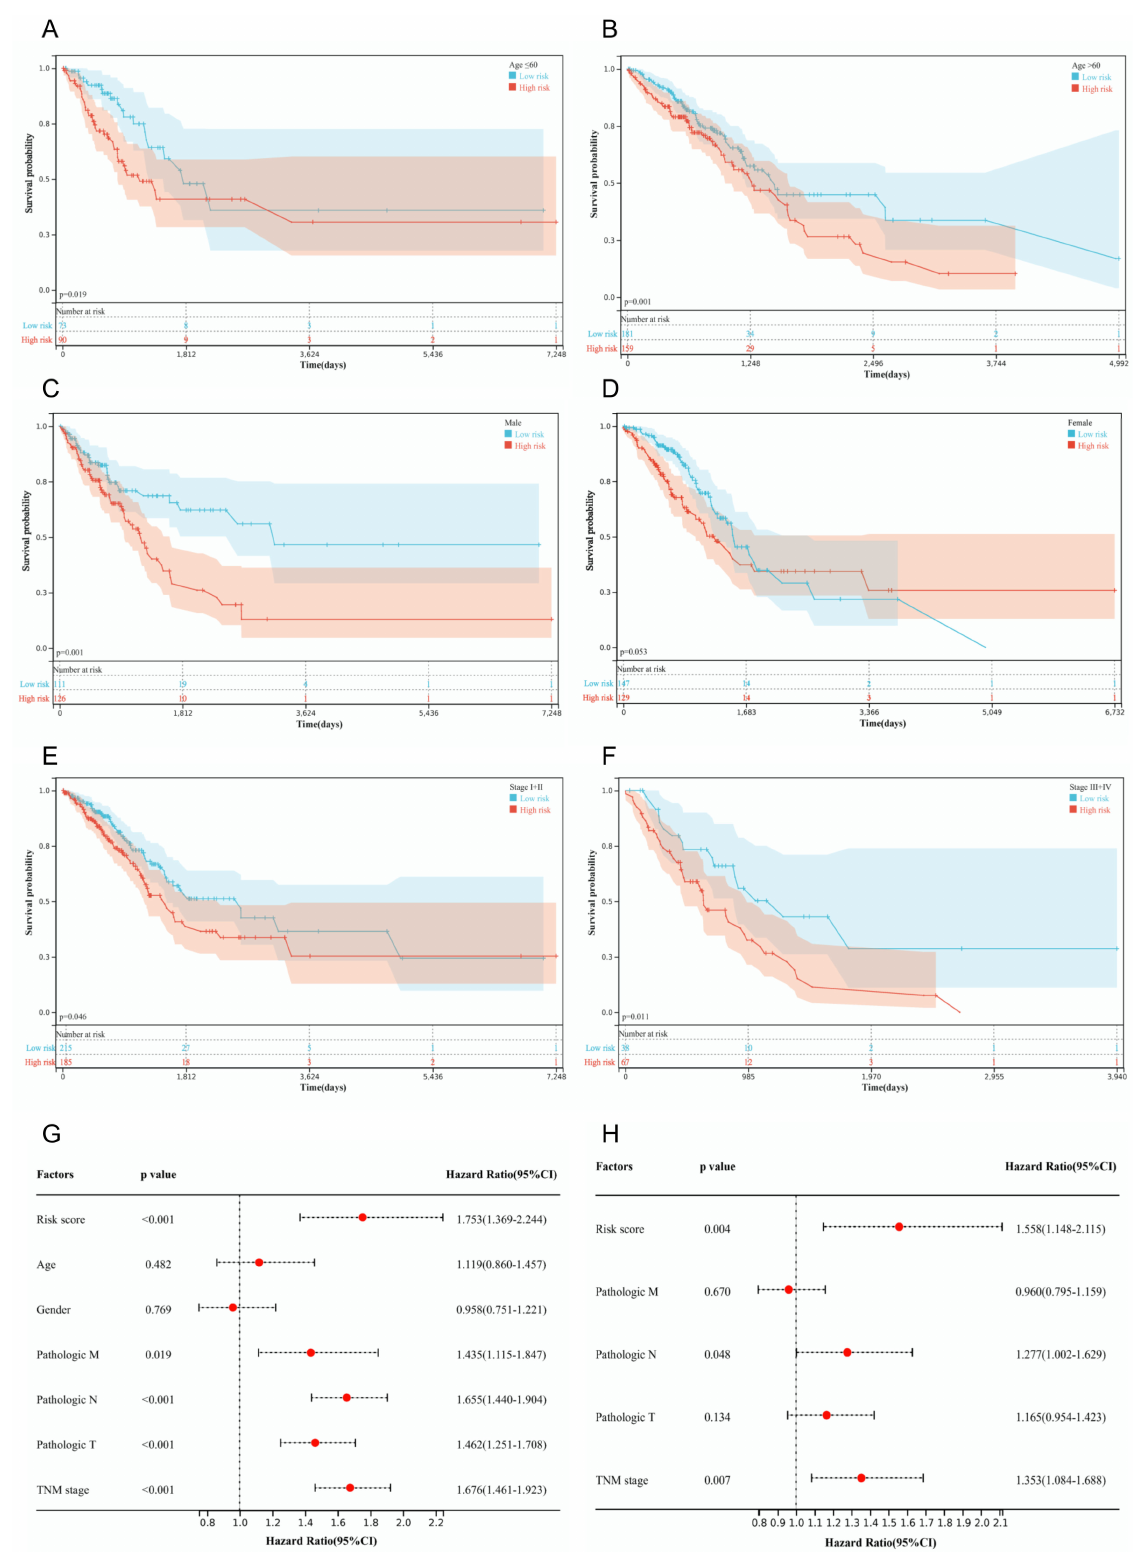
Figure 3. Stability and independence of the prognostic risk model. Survival times of patients among different ( A , B ) age, ( C , D ) gender, and ( E , F ) TNM stage subgroups. ( G ) Univariate and ( H ) multivariate Cox regression analyses on risk score, age, gender, M, N, T, and TNM